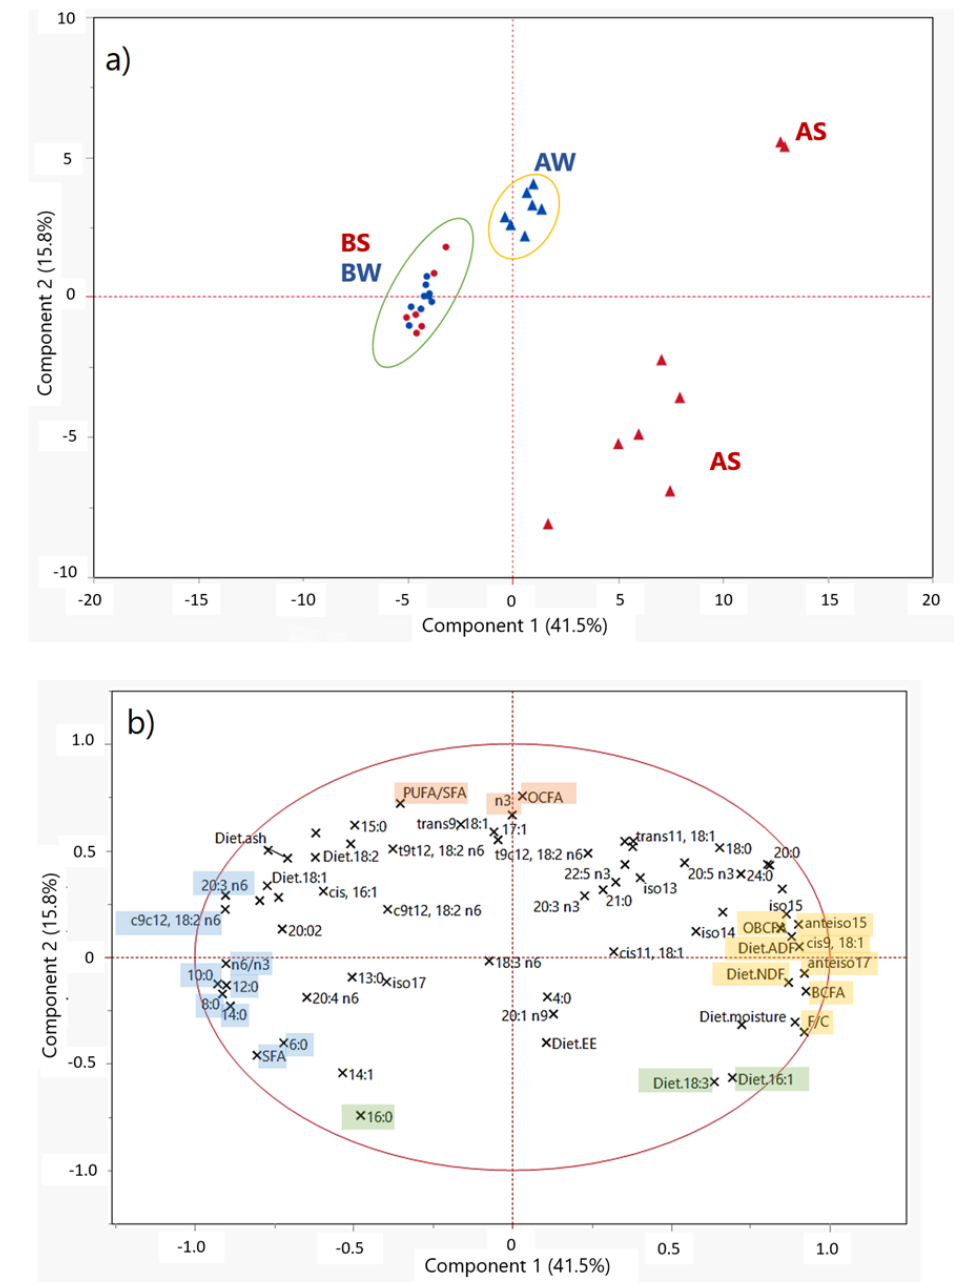
Figure 1. ( a ) PCA score plot. Legend: triangles—milk collected from farm A; points—milk collected from farm B; red—summer samples; blue—winter samples. ( b ) PCA loading